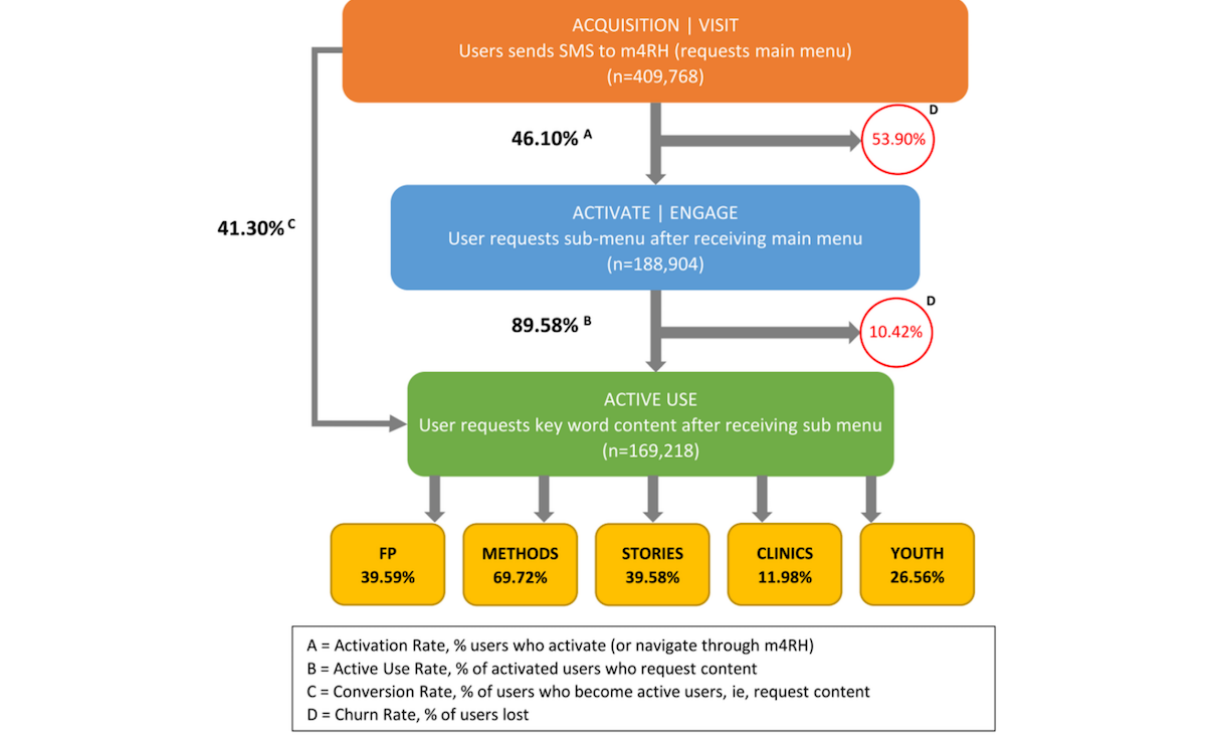
Figure 3. Mobile for Reproductive Health respondent progression. m4RH: Mobile for Reproductive Health; SMS: short message